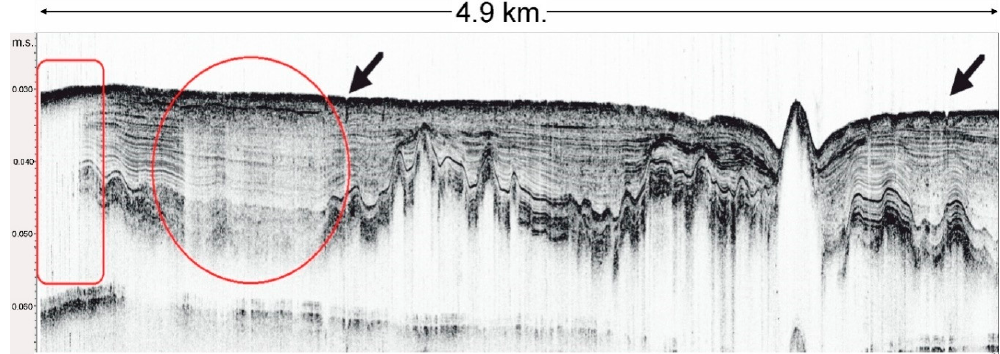
Figure 13. The seismic profile with the gas accumulations (shown in red) in the layers of the Middle and Early Holocene sediments (the position, see Figure 1). The arrows show the location of the pockmarks. m.s.—milliseconds.